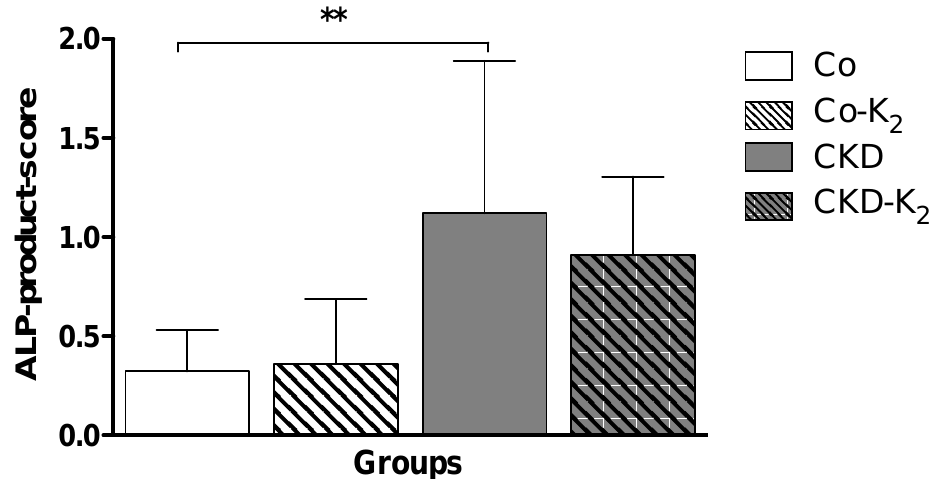
Figure 2. Aortic calcium content. Measurement of aortic calcium content was performed by atomic absorption spectrometry and expressed as µ g Ca/mg dry weight tissue. CKD animals display a significant increase in aortic calcium content compared to Co-K 2 animals. Co = control group; Co-K 2 = MK-7 supplemented control group; CKD = 5/6 nephrectomized group; CKD-K 2 = MK-7 supplemented 5/6 nephrectomized group; mg = milligrams; µg = micrograms. Significant differences: * p < 0.05.